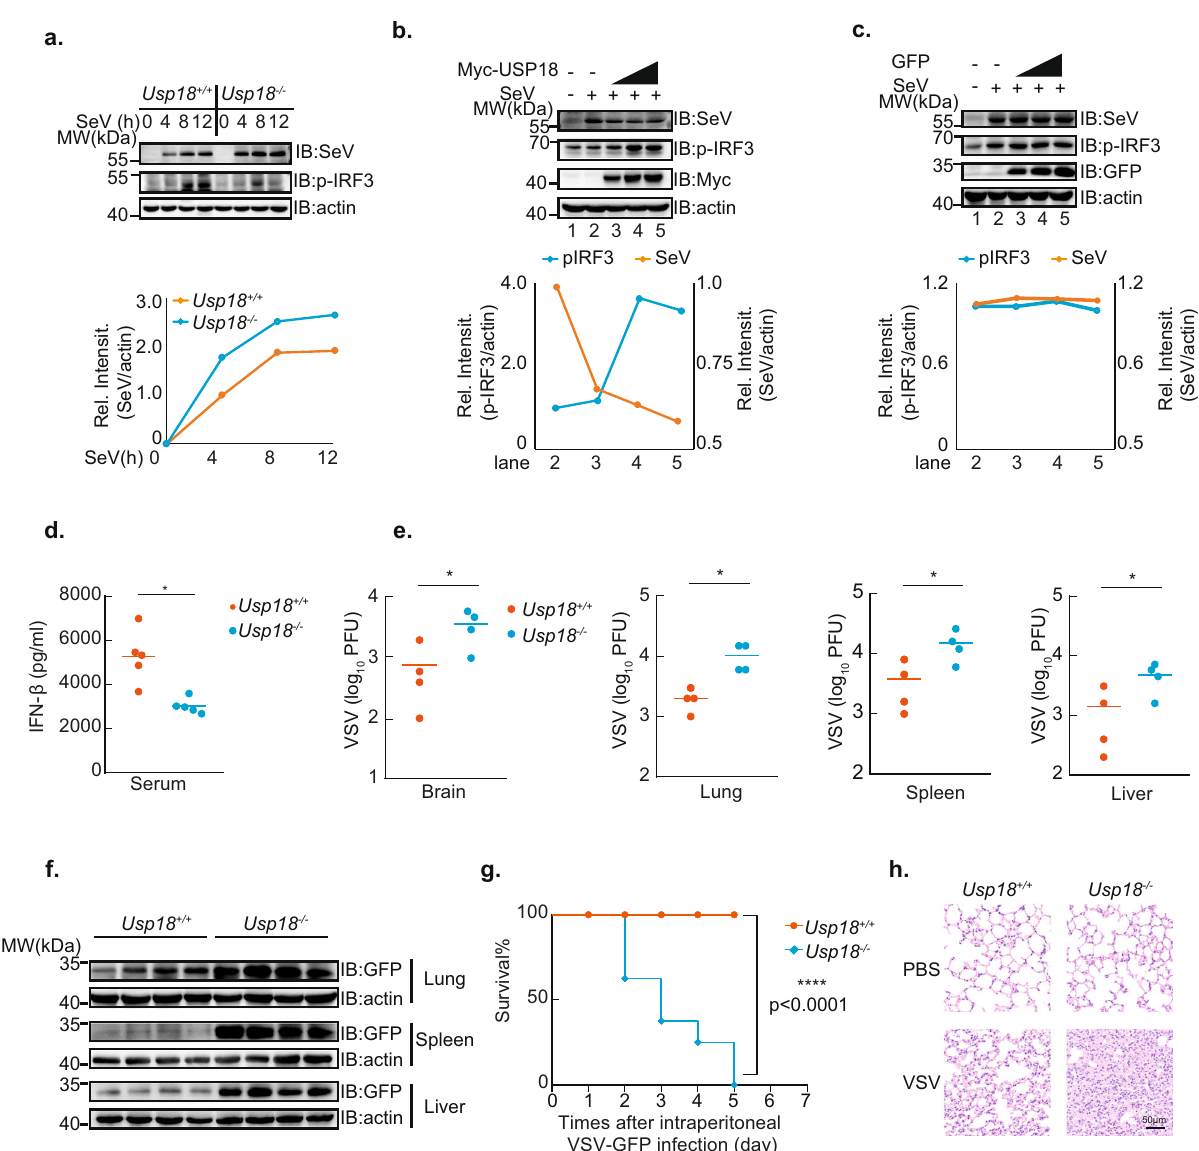
Fig. 3 USP18 de fi cient mice are susceptible to RNA virus infection. a Immunoblot analysis of SeV in lysates of Usp18 + / + and Usp18 − / − MEFs infected with SeV for 0 – 12 h. b Immunoblot analysis of SeV in lysates of 293T cells transfected with Myc-USP18 in different dosages followed by infection with SeV for 8 h. c Immunoblot analysis of SeV in lysates of 293T cells transfected with EGFP-N1 plasmid in different dosages followed by infection with SeV for 8 h. d ELISA analysis of IFN- β level in serum of Usp18 + / + and Usp18 − / − mice ( fi ve per group) infected for 12 h by intraperitoneal injection of VSV (2 × 10 7 PFU per mouse). Representative data were collected and expressed as mean ± SD from at least three independent experiments. Two-tailed Student ’ s t test was performed, * p = 0.0114. e Plaque assay of VSV titers in the brain, spleen, liver, and lungs of Usp18 + / + and Usp18 − / − mice (four per group) infected for 36 h by intraperitoneal injection of VSV (2 × 10 7 PFU per mouse). Representative data were collected and expressed as mean ± SD from at least three independent experiments. Two-tailed Student ’ s t test was performed, * p = 0.0464, * p = 0.0178, * p = 0.0468, * p = 0.0428 in sequence. f Immunoblot analysis of VSV-GFP in the spleen, liver, and lungs of Usp18 + / + and Usp18 − / − mice (four per group) as in e . g Survival (Kaplan – Meier curves) of Usp18 + / + and Usp18 − / − mice (eight per group) injected intraperitoneally with VSV (1 × 10 8 PFU per mouse), with log rank test [Mantel-Cox], with **** p < 0.0001. h Hematoxylin-and-eosin-stained images of lung sections from mice as in e . Scale bars, 50 µ